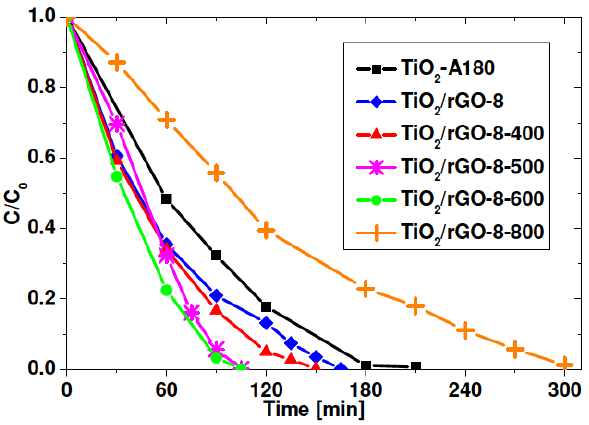
Figure 1: Acid blue decomposition degree under UV light